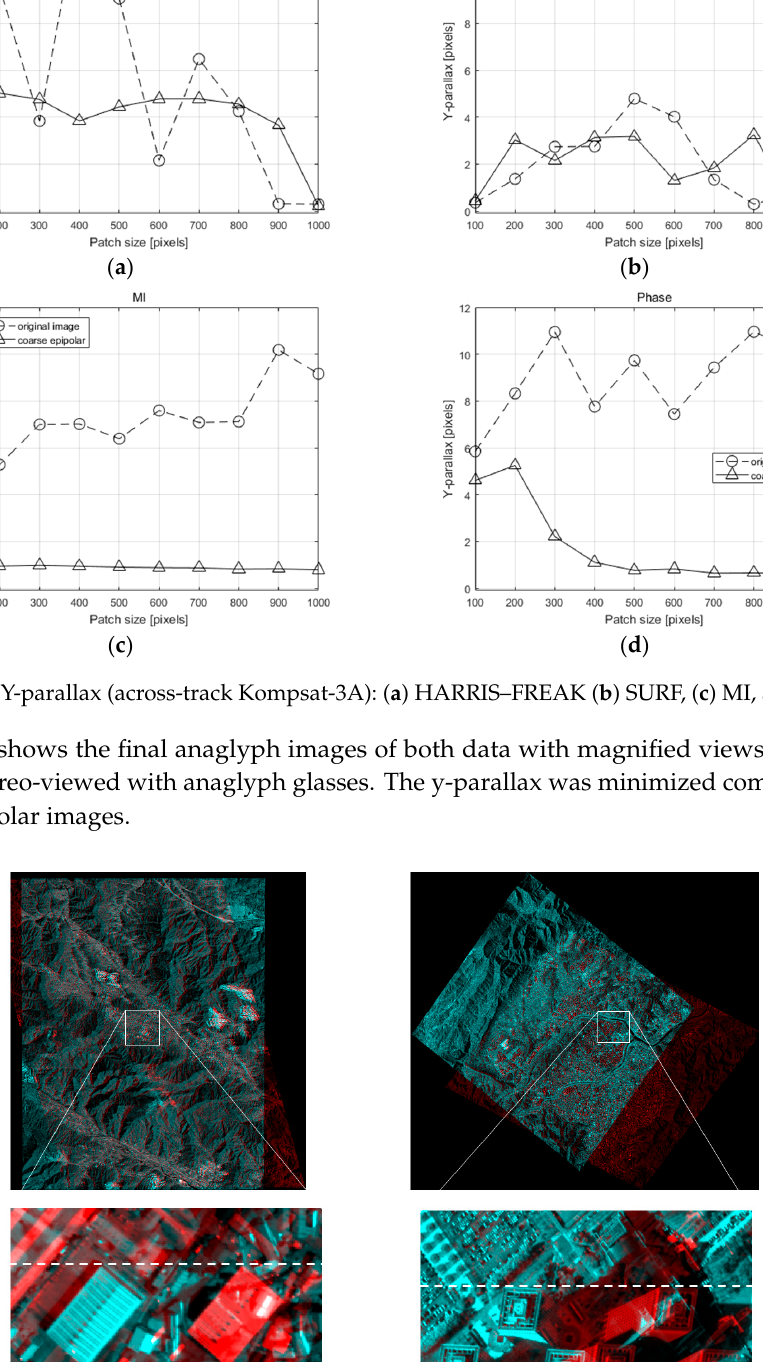
across-track Kompsat-3A.